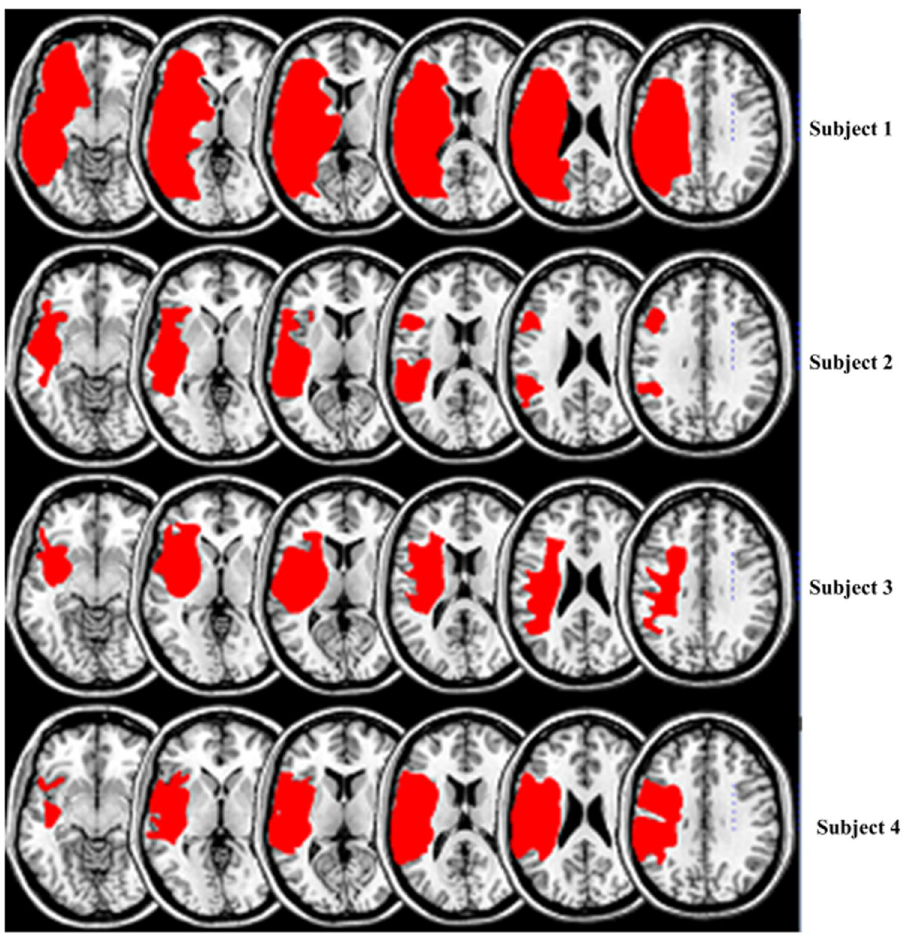
Figure 9. Overlap plot of damage locations in our 4 exemplar subjects. Subject 1: total lesion volume 359.4 cm 3 , Subject 2: total lesion volume 76.1 cm 3 , Subject 3: total lesion volume 99.24 cm 3 , Subject 4: total lesion volume 206.36 cm 3 .